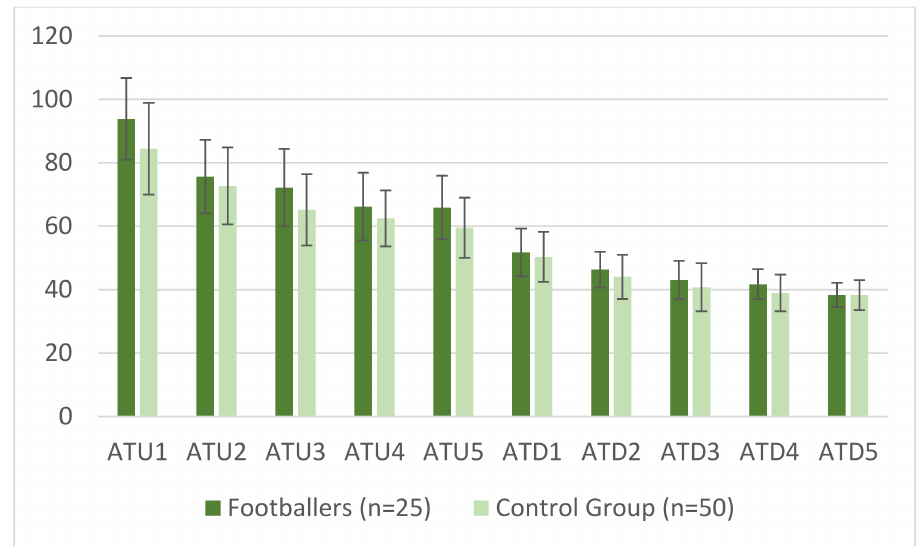
Figure 7. Adaptation Test—sway energy for 5 dorsiflexion (ATU) and 5 plantarflexion (ATD) condition for footballers and control